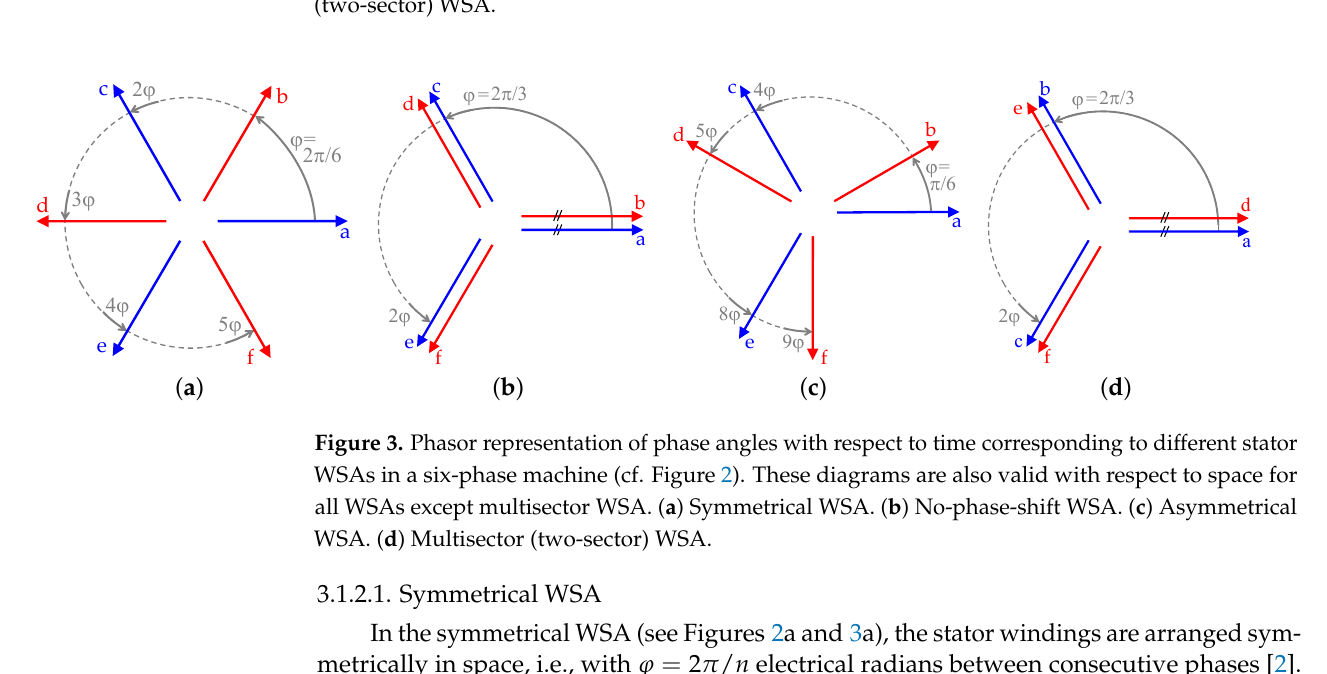
Figure 2. Stator WSAs in a six-phase machine, using blue and red colors for each three-phase winding set (assuming three-phase splitting). Concentrated full-pitch windings are considered for simplicity. ( a ) Symmetrical WSA. ( b ) No-phase-shift WSA. ( c ) Asymmetrical WSA. ( d ) Multisector (two-sector) WSA.